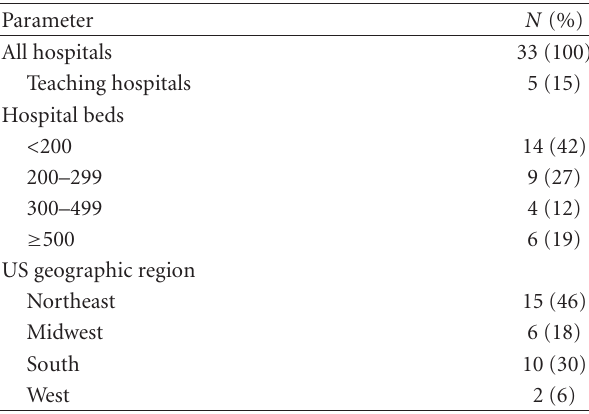
Table 1: Hospital